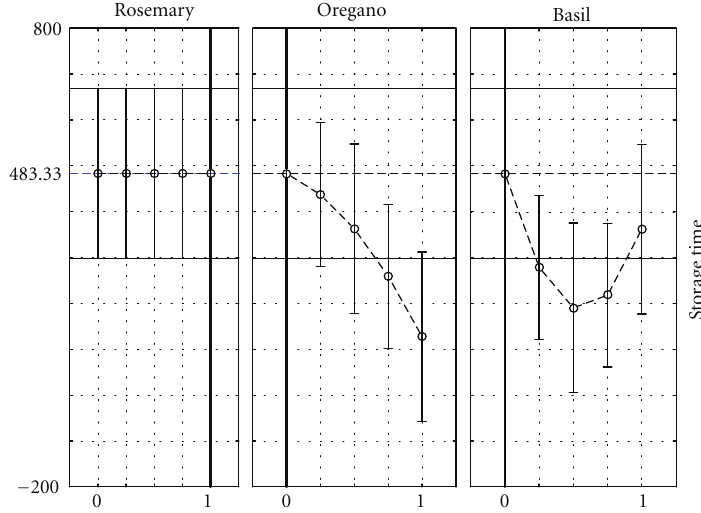
F 8: Optimum conditions pro�le for variables according to Rancimat